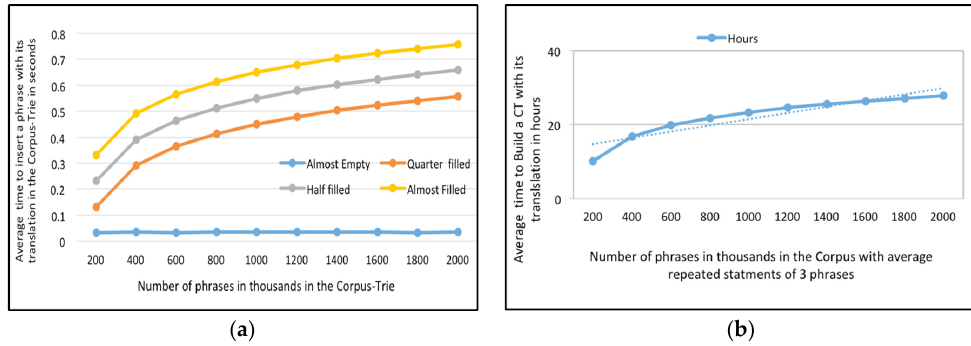
Figure 5. ( a ) Average time to insert a phrase with its translation in the Corpus-Trie in seconds versus Number of phrases in thousands in the Corpus-Trie for the English-Arabic parallel corpora; ( b ) The cost of Corpus-Trie construction (the number of phrases which are repeated in the corpus is in the average of three phrases), for the English-Arabic parallel corpora.